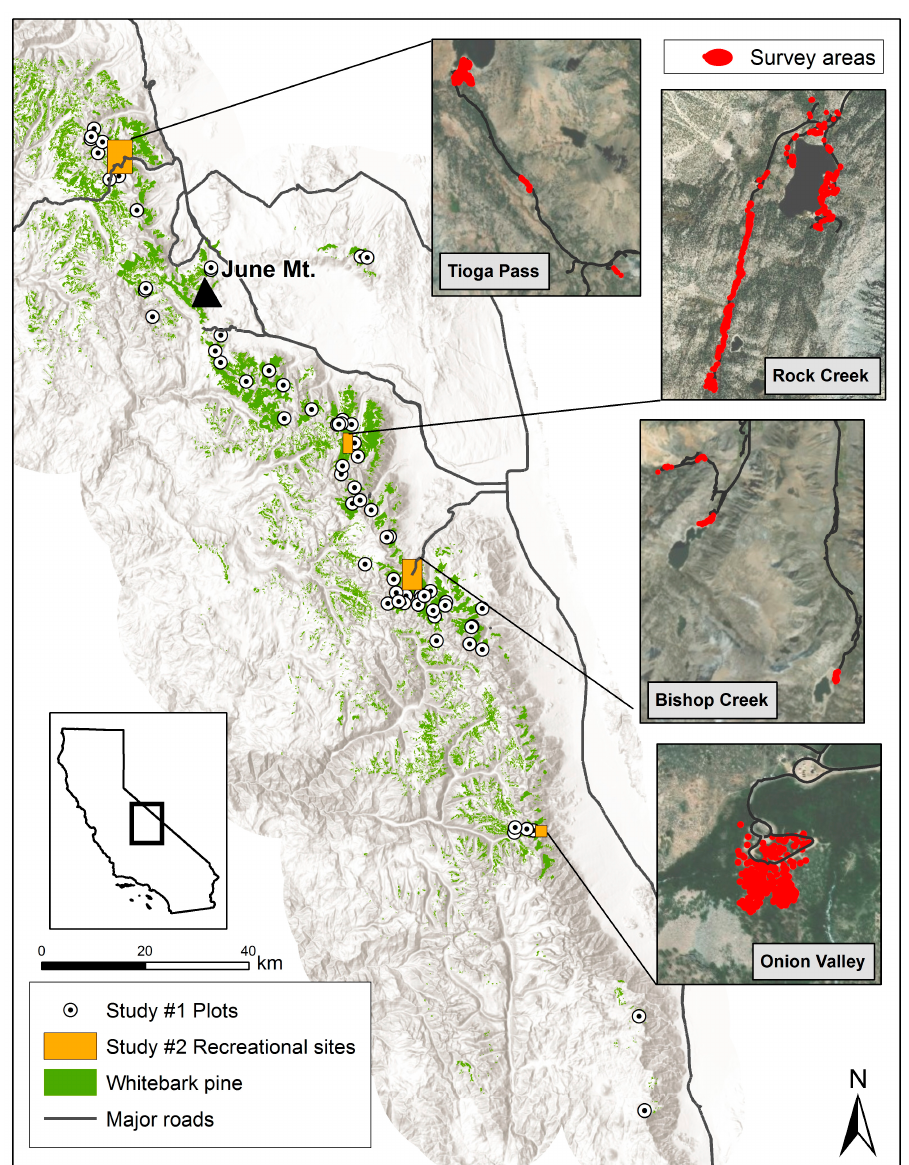
Figure 2. Map of study area in eastern California, USA, displaying Study #1 plots, the four recreational sites surveyed in Study #2, and the June Mt. case study area.